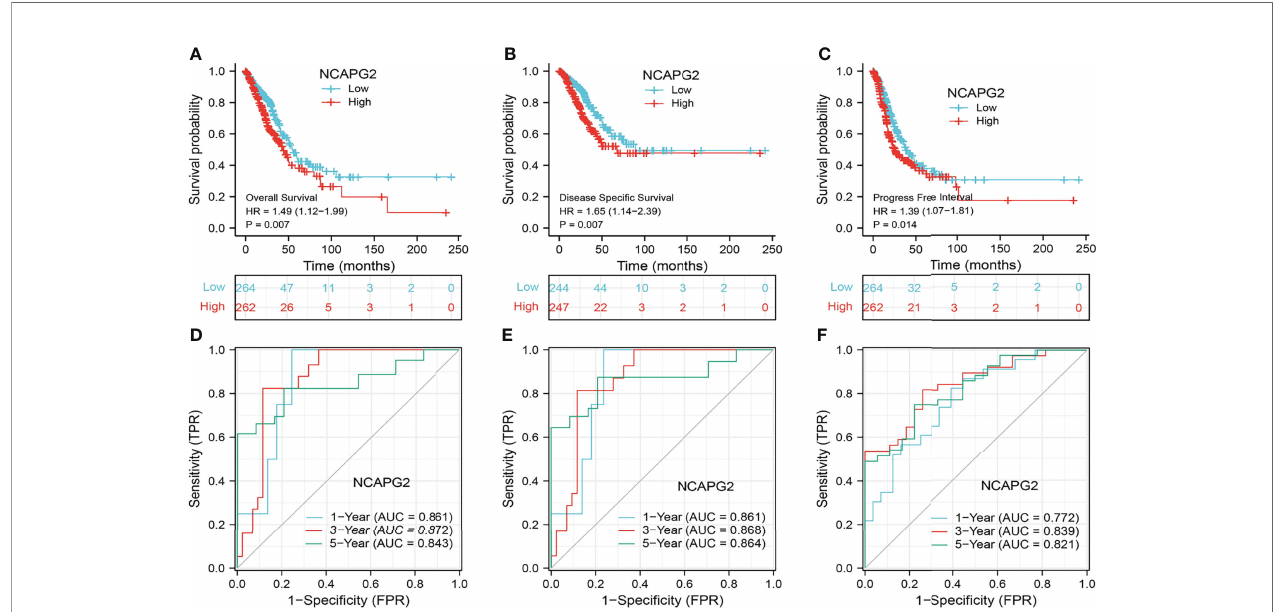
FIGURE 4 | Prognostic and diagnostic value of NCAPG2 (A – C) Kaplan – Meier survival curves showed that lung adenocarcinoma patients with high NCAPG2 expression exhibited poor overall survival, disease-speci fi c survival, and progression-free survival of NCAPG2 in LUAD determined by the TCGA-LUAD dataset. (D – F) Time-dependent ROC curves were used to determine the diagnostic value of NCAPG2 in lung